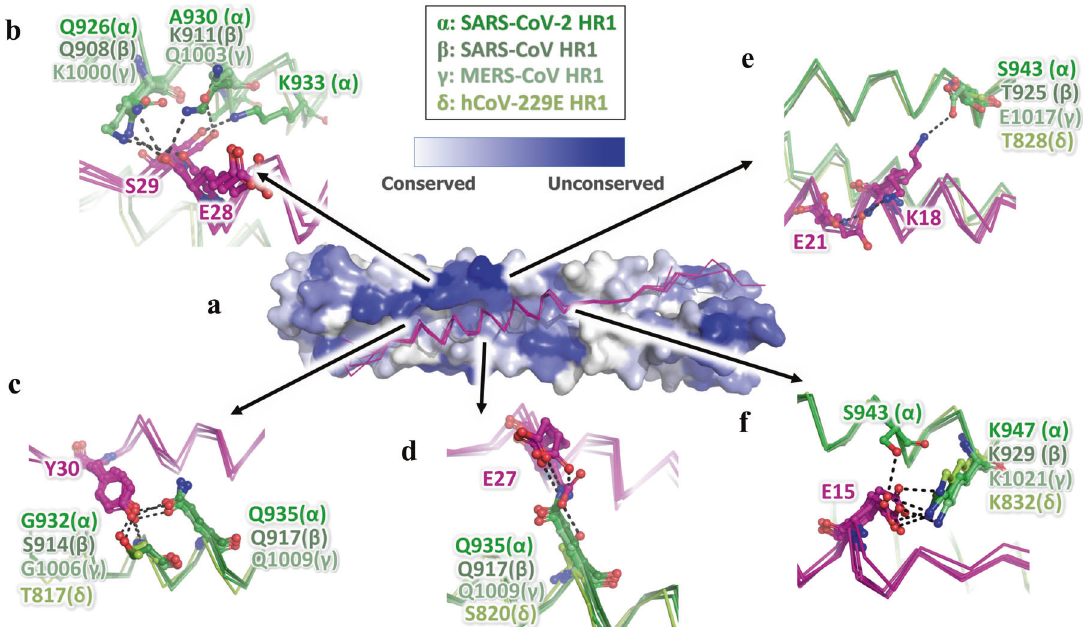
Fig. 5 The critical residues in EK1 can fl exibly interact with variable residues in HR1 region of HCoVs mainly through the hydrophilic interaction. a The EK1 peptides in their complex structures with SARS-CoV-2 ( α , PDB entry 7C53), SARS-CoV ( β , PDB entry 5ZVM), MERS-CoV ( γ , PDB entry 5ZVK) and hCoV-229E ( δ , PDB entry 5ZUV) are superposed together, shown as ribbon in magentas. The SARS-CoV-2 HR2 trimer is shown as surface and colored according to the residue conservations. b – f The interaction details of EK1 against HR1 in different HCoVs are shown. Important residues are shown in sticks and